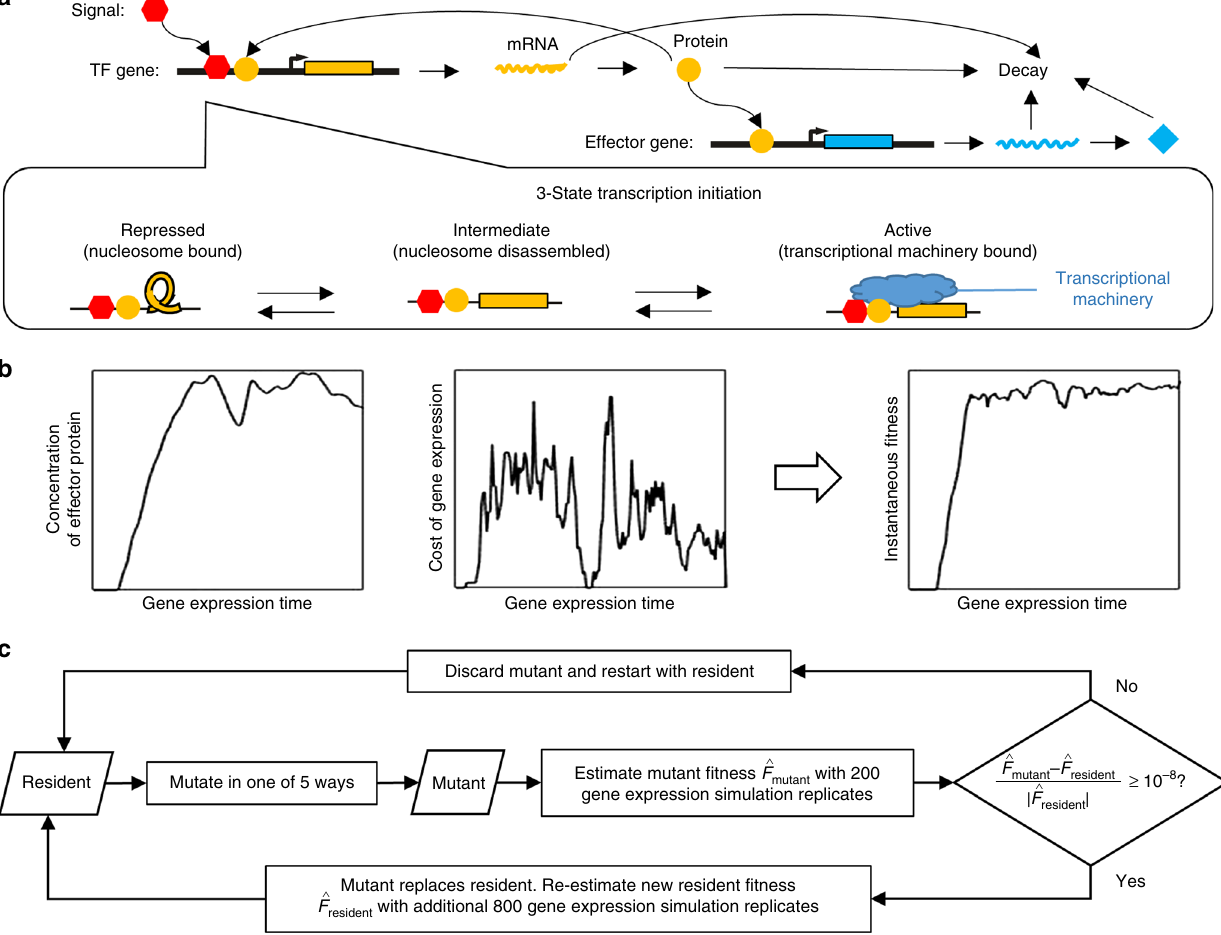
Fig. 1 Overview of the model. a Simulation of gene expression phenotypes. We show a simple TRN with one TF (yellow) and one effector gene (blue), with arrows for major biological processes simulated in the model. b Phenotype – fi tness relationship. Fitness is primarily determined by the concentration of an effector protein (here shown as bene fi cial as in Eq. 4, but potentially deleterious in a different environment as in Eq. 5), with a secondary component coming from the cost of gene expression (proportional to the rate of protein production), combined to give an instantaneous fi tness at each moment in gene expression time. c Evolutionary simulation. A single resident genotype is replaced when a mutant ’ s estimated fi tness is high enough. Stochastic gene expression adds uncertainty to the estimated fi tness, allowing less fi t mutants to occasionally replace the resident, capturing the fl avor of genetic drift